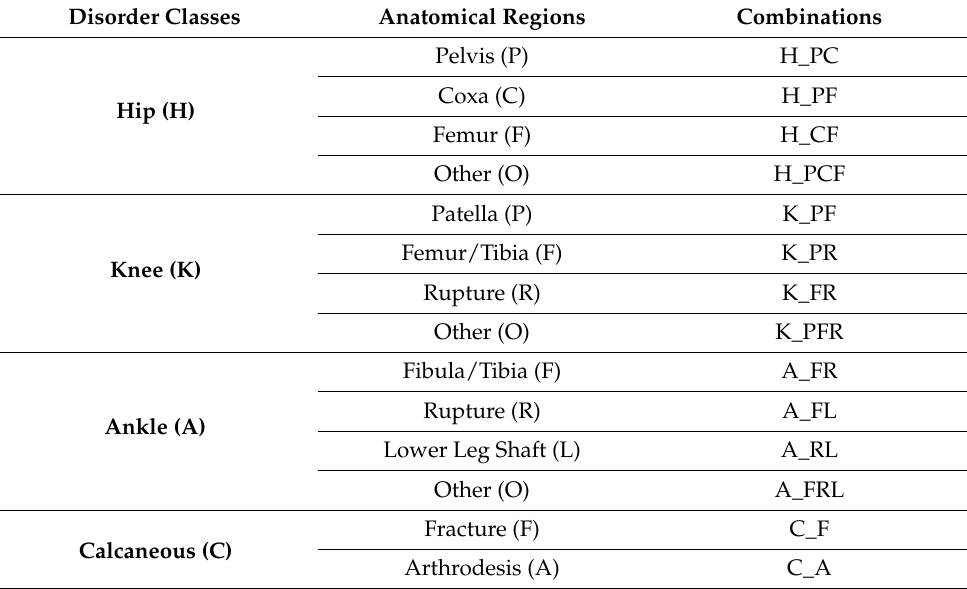
Table 1. Anatomical region and their